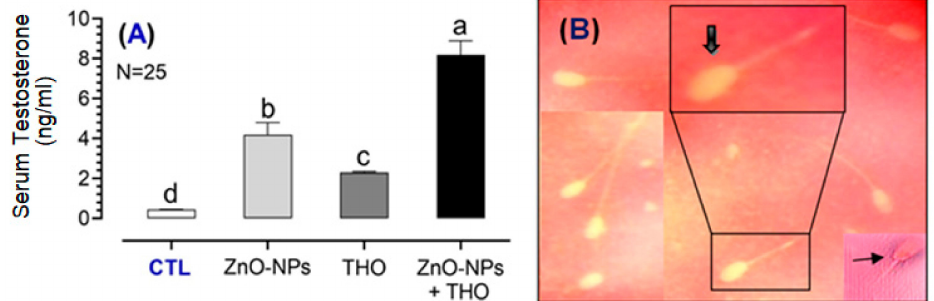
Figure 5. Serum concentrations of testosterone in response to supplementation with ZnO-NPs, THO, or ZnO-NPs + THO vs. control (CTL), respectively, is shown in ( A ). All treated groups significantly increased the testosterone concentrations with variable potencies, compared to control. Also, the combined treatment; ZnO-NPs was the most potent stimulator. Letters on bars (a, b, c, d) denote the significant di ff erences between groups at p < 0.05. Alive, non-stained white (Thick arrow), and dead, red-stained sperm cell (thin arrow) are shown in ( B ). The red eosin stain could not penetrate the living sperm cells which appear white, but those dead spermatozoa are stained red with eosin, and so the sperm vitality could be distinguished and